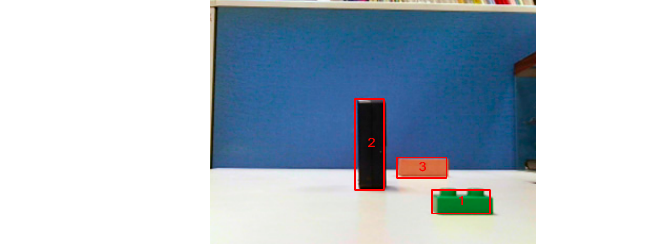
Figure 16. Results of the proposed stereo vision method. ( a ) Left image. ( b ) Right image. ( c ) Image after color classification. ( d ) Image after CCL. ( e ) Depth map.